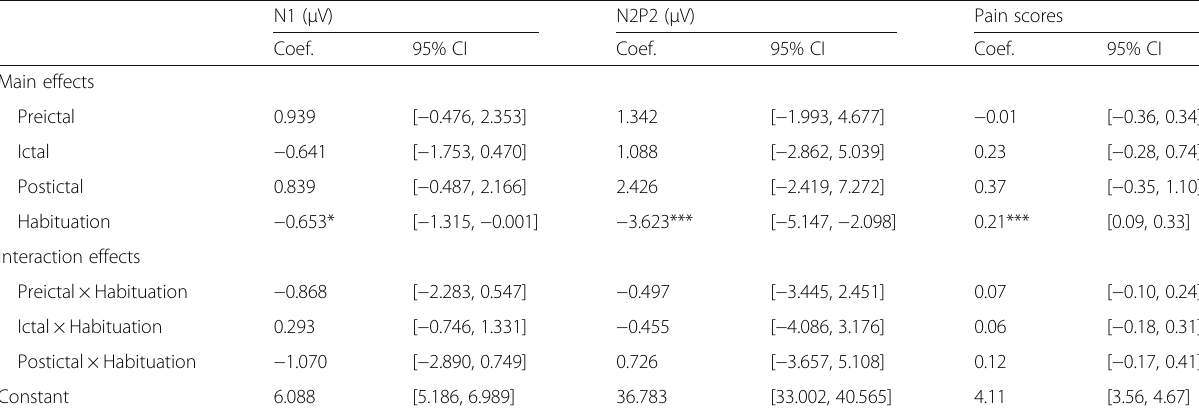
Table 3 Estimated magnitudes and habituation of N1, N2P2 and pain scores by phase N1 ( μ V) N2P2 ( μ